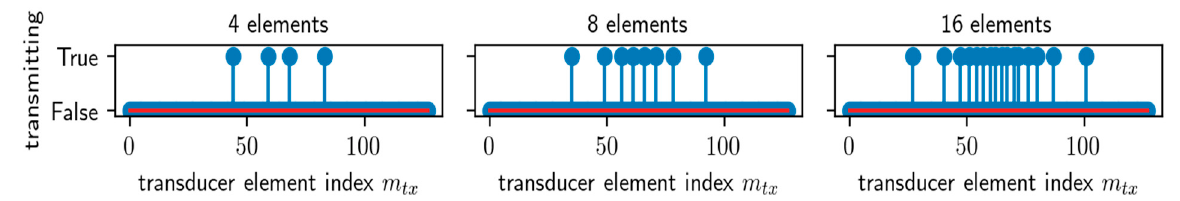
Figure 5. Illustration of the transmit patterns chosen for the scenario at hand based on the binary map displayed in Figure 4c.